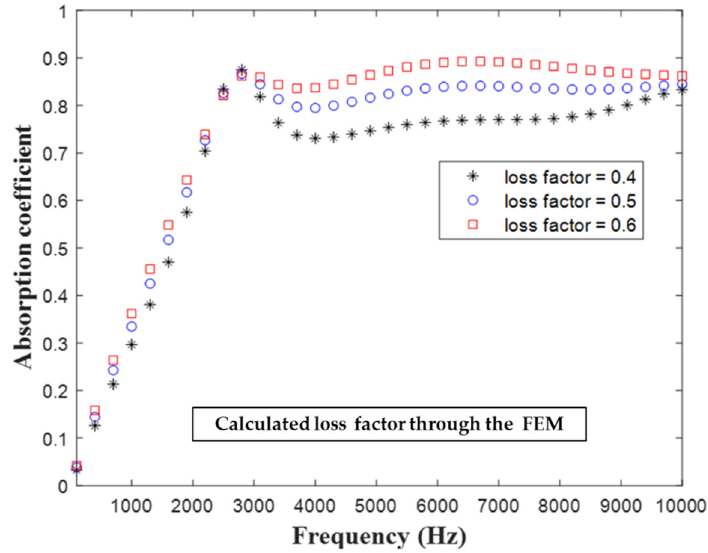
Figure 16. Influence of the loss factor of the substrate of the hybrid metastructure on the structure’s sound absorption coefficient. sound absorption